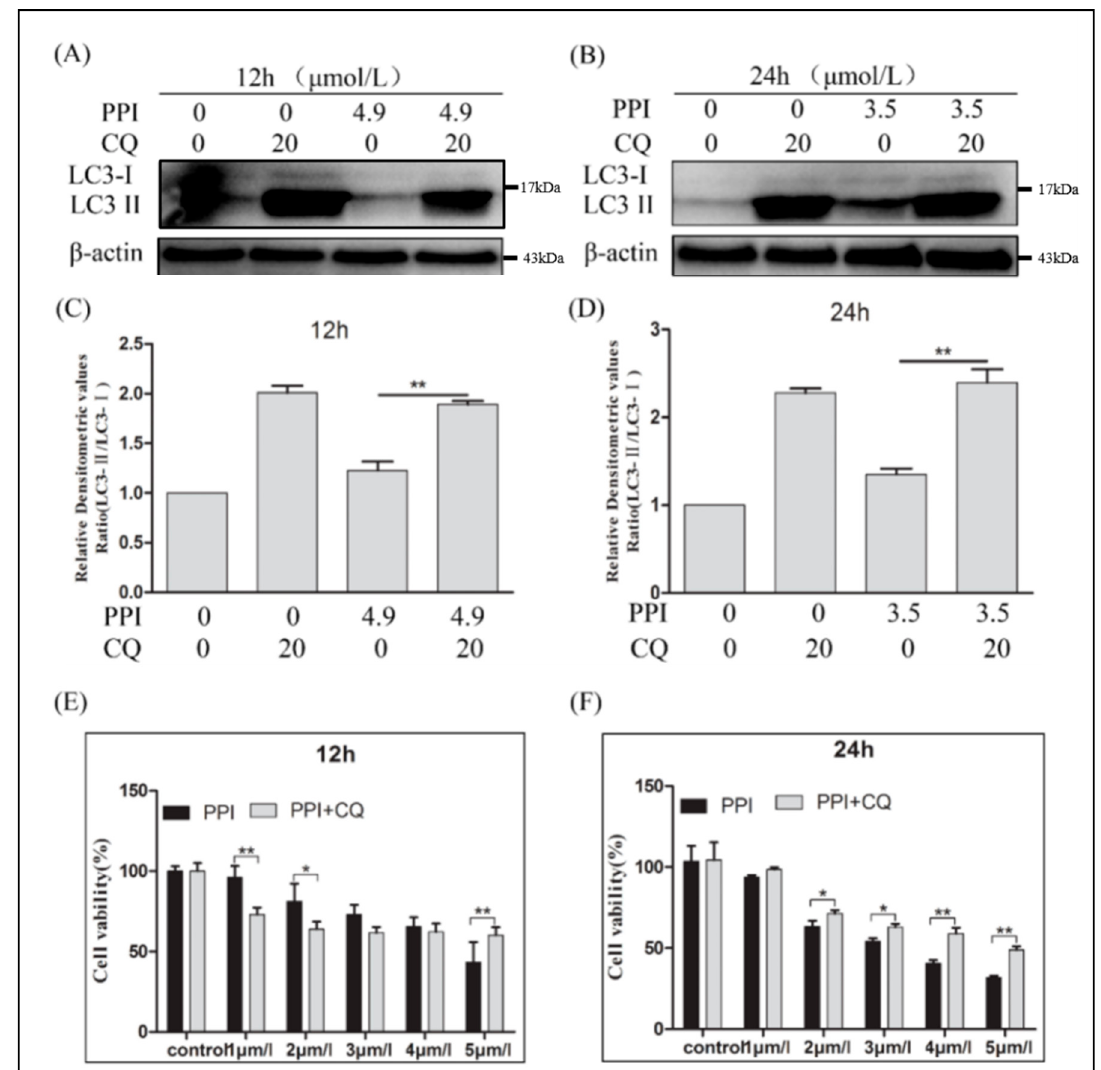
Figure 4. Blocking autophagy inhibits apoptosis induced by PPI. ( A , B ) LC3 protein level was examined by Western blot assay after treatment with PPI and CQ for 12 and 24 h, respectively. ( C , D ) The quantification of the ratio of LC3 ‐ II to LC3 ‐ I. ( E , F ) Cell viability was evaluated by MTT assay after treatment with PPI and CQ for 12 and 24 h, respectively. n = 3, the data are presented as means ± SEM. * p < 0.05; ** p < 0.01.